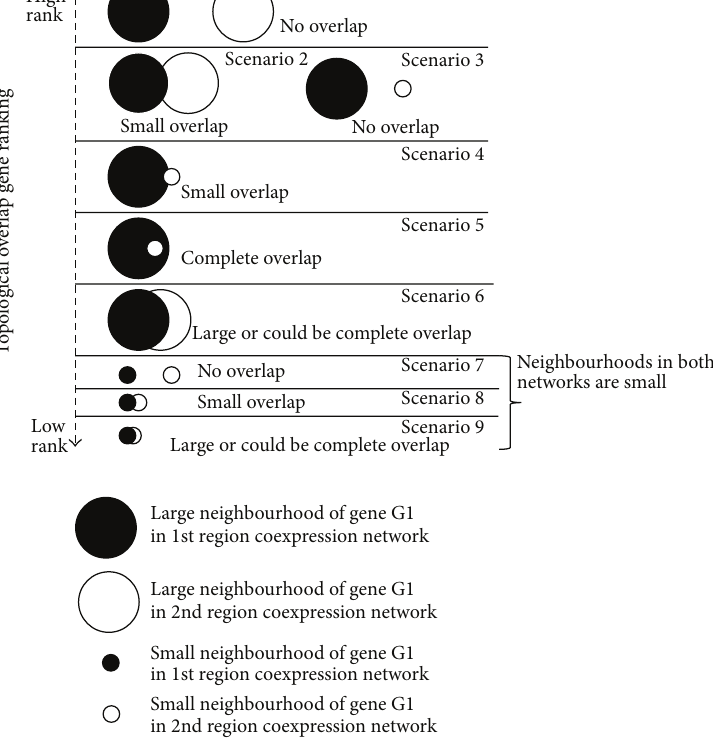
Figure 4: Ranking of low TO genes. Nine possible scenarios of how neighborhoods overlap when considering neighborhood size and neighborhood overlap size of a gene, simultaneously, in two regional coexpression networks. Scenarios 1, 2, and 6 occur if the neighborhood of a gene in both regional networks is large and either they have zero (scenario 1), small (scenario 2), or large/complete (scenario 6) overlap of their direct neighbors. In scenarios 3, 4, and 5, the gene has a large neighborhood in one network and a small neighborhood in the other coexpression network. This also could lead to three possible kinds of overlap: zero (scenario 3), small (scenario 4), or large/complete overlap (scenario 5). Finally, in scenarios 7, 8, and 9, both neighborhoods of the gene are small and could have either zero (scenario 7), small (scenario 8), or large/complete overlap (scenario 9). The scenarios at the top of the figure have a higher rank than the ones at the bottom. Scenarios 1, 2, and 3 have a higher rank because the gene has either (1) a large neighborhood in both regional networks but small/no overlap of its neighbors or (2) large difference of its neighborhood in the two regional coexpression networks and no overlap of its neighbors whatsoever. Scenarios 4 and 5 have a large difference in neighborhoods but small or complete overlap of their neighbors. A gene is ranked the highest if it has a large difference in its neighborhood size and no overlap of its neighbors. This gene is assumed to have high activity (as indicated by the large neighborhood size) yet different biological roles (as indicated by the zero overlap of its neighborhoods) in the two different